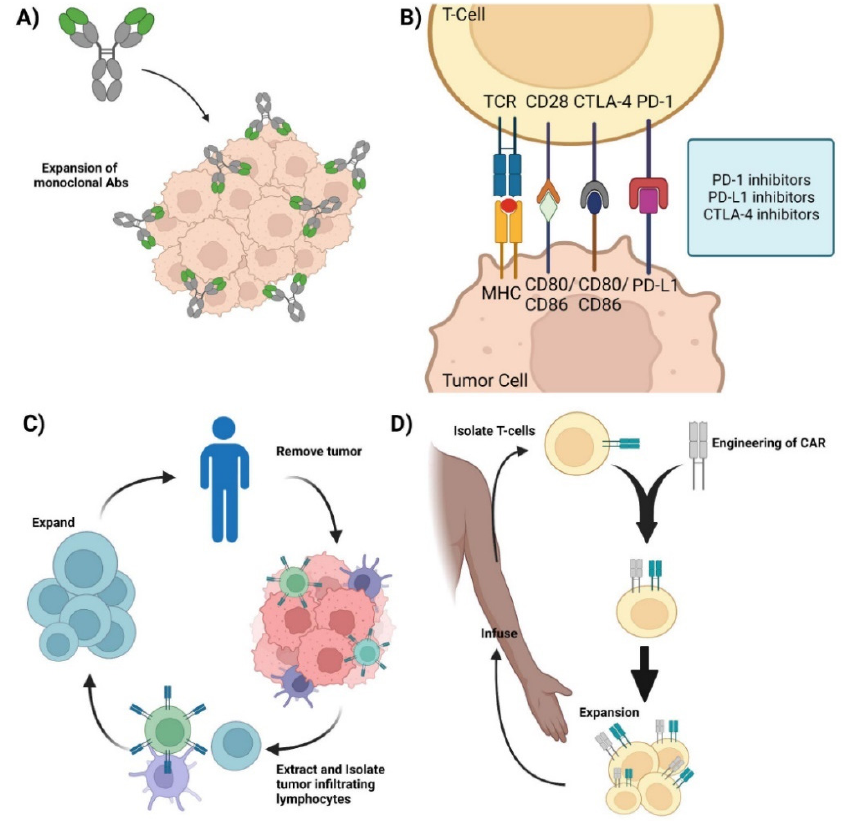
Figure 1. Current immunotherapies. ( A ) Monoclonal antibodies —representation of mAbs and the mechanism involved in mounting an immune response against cancer cells. ( B ) Immune checkpoint inhibitors —Graphic showcasing the immune crosstalk that occurs between T cells and tumor cells and the respective ligands and receptors targeted using mAbs. ( C ) Adoptive Cell Therapy —Graphic showing how TILs are synthesized by removing the respective tumor from the patient, isolating, extracting, and expanding the appropriate TILs, and its re-infusion back into the patient for therapy. ( D ) Chimeric Antigen Receptor T-cell therapy —Representation of CAR-T synthesis and production. Isolate T cells from the patient and mount a synthetic CAR onto the host T cells. Expand the modified T cell population and re-infuse back into the patient. Credits: Images were created using BioRender. Other ACTs include T-cell Receptor-engineered T cell (TCR-T) and Chimeric